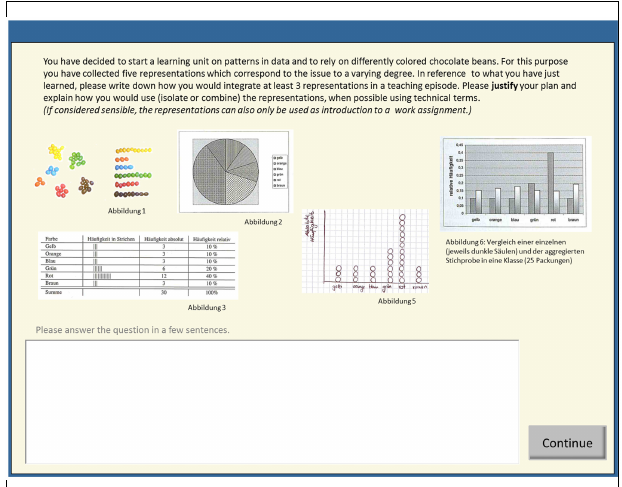
FIGURE 1 |Translated screenshot of a mathematics classroom scenario. Student teachers completed this task individually.They were asked to combined different elements in accordance with the principles learned in the preceding learning